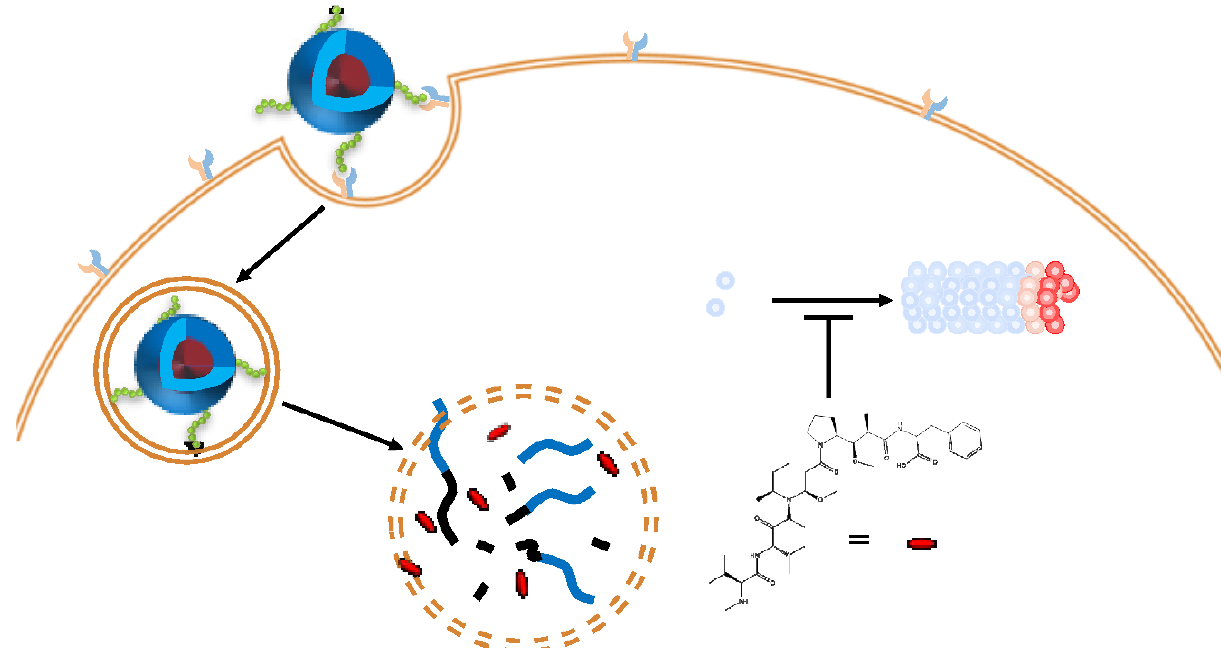
Scheme 1. Schematic actions of MMAF delivery systems with active targeting ability and ROS-responsiveness. The nanoparticles are efficiently internalized into the tumor cells. Intracellular ROS facilitates the disruption of the nanoparticles, which release MMAF to exert the anticancer effects by inhibiting tubulin polymerization.